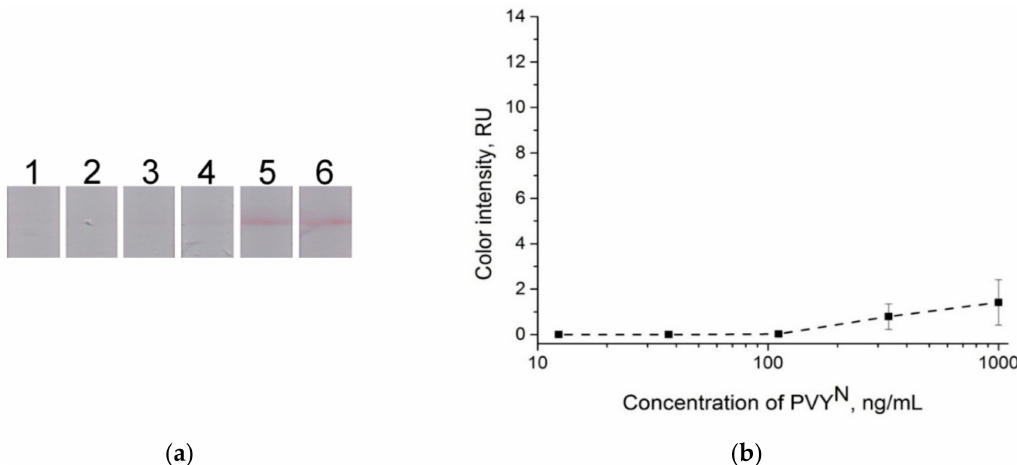
Figure 5. Conventional lateral flow immunoassay (LFIA). ( a ) Lateral flow strips after testing of the samples containing PVY N in buffer solution, test strip 1 is negative control (0 ng · mL − 1 ), and test strips 1–5, PVY N concentration: 12 ng · mL − 1 , 37 ng · mL − 1 , 111 ng · mL − 1 , 333 ng · mL − 1 , and 1000 ng · mL − 1 ,